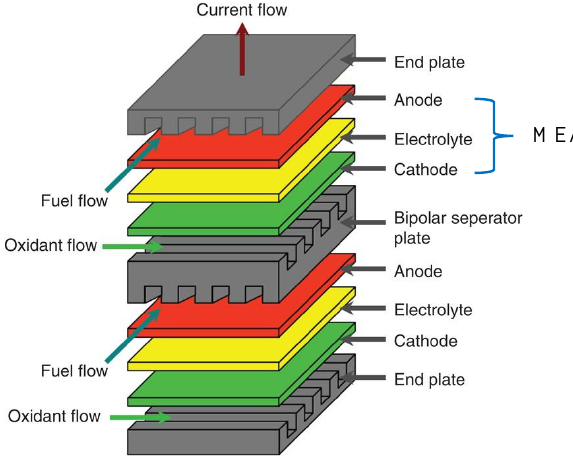
Figure 2. Planar solid oxide fuel cell stack with MEA indication [9].